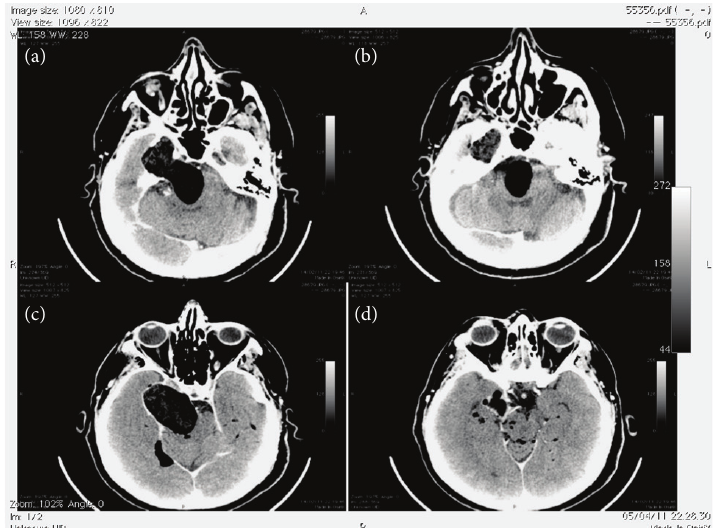
F 1: HRCT in axial plane showed heterogeneous hypodense lesion extending to middle and posterior fossa ((a) and (b)), and multiple bilateral hypodense collected disseminated along cerebral cisternal and cortical spaces ((c) and (d)).